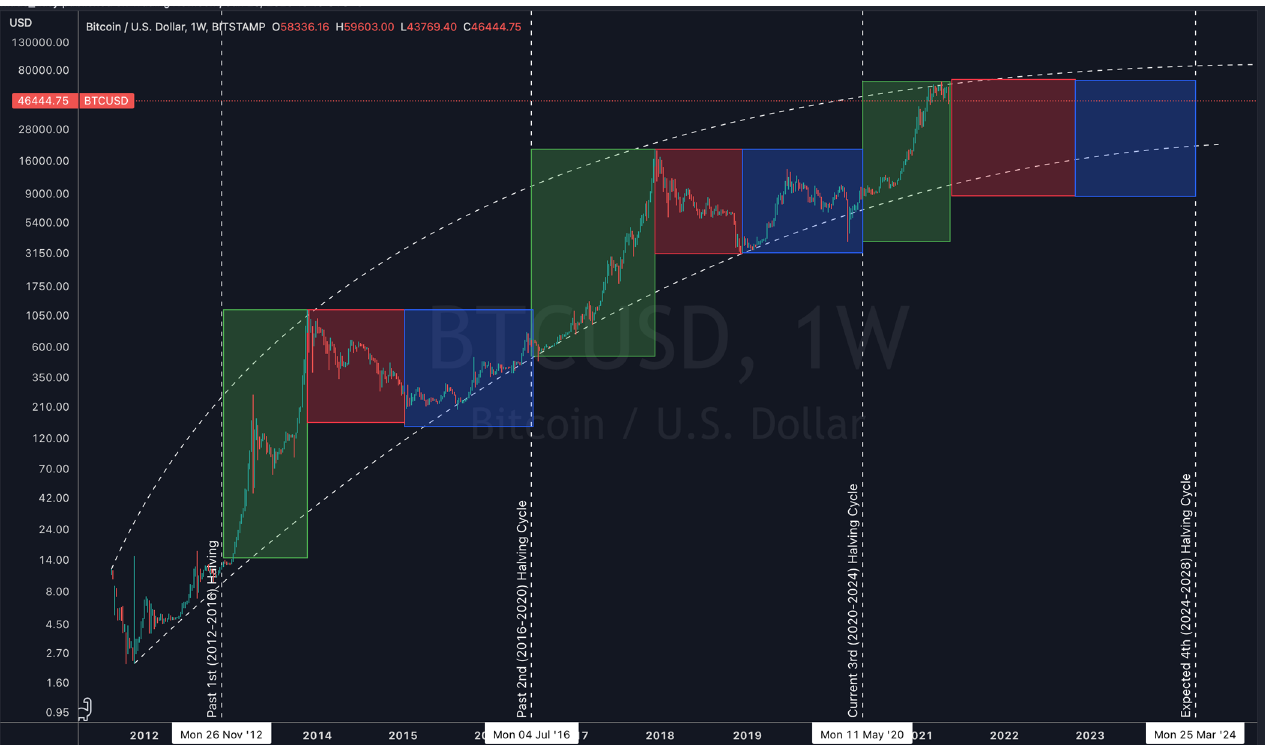
Figure 1. The Bitcoin Halving Cycle. Figure 1 represents a log-scale weekly candlestick chart of the Bitcoin price and illustrates the consistent occurrence of the 3 distinct phases (bull market, bear market, recovery phase) during each cycle. The green box represents the bull market, the red box represents the bear market, and the blue box represents the recovery phase. The first halving cycle occurred on 28 November 2012. The second halving cycle occurred on 9 July 2016. The third halving cycle occurred on 11 May 2020. The start of each halving cycle is indicated by a vertical line marking the date of the beginning of the respective weeks, as Figure 1 is a weekly chart.